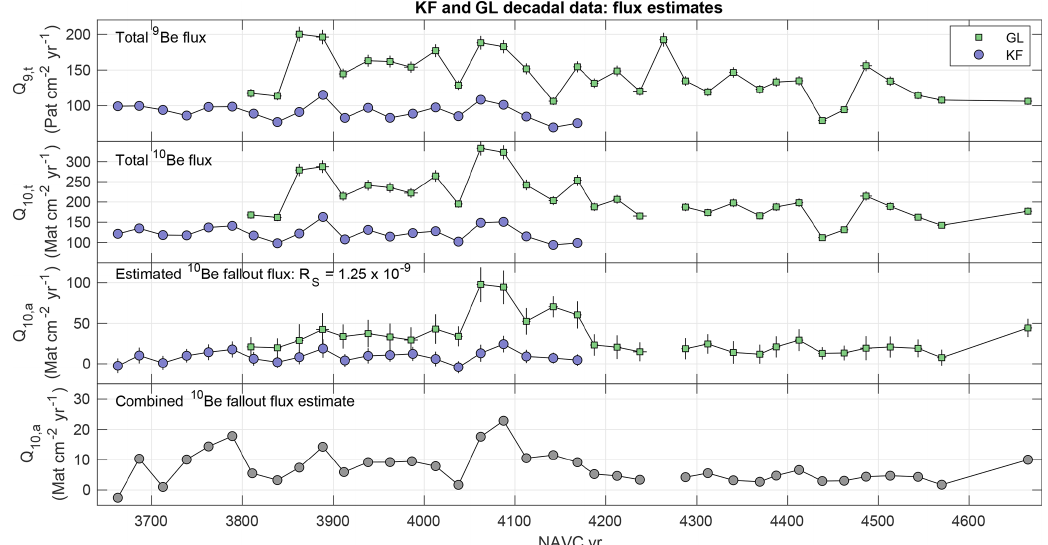
Figure 17. Be fluxes calculated for KF and GL decadal records. Upper panels: total 9 Be and 10 Be fluxes to sediment. Third panel: 10 Be fallout flux estimates using Eq. (1) for constant R S . Lower panel: combined estimate computed by linearly scaling the estimate from KF to force agreement in the period of overlap of the two